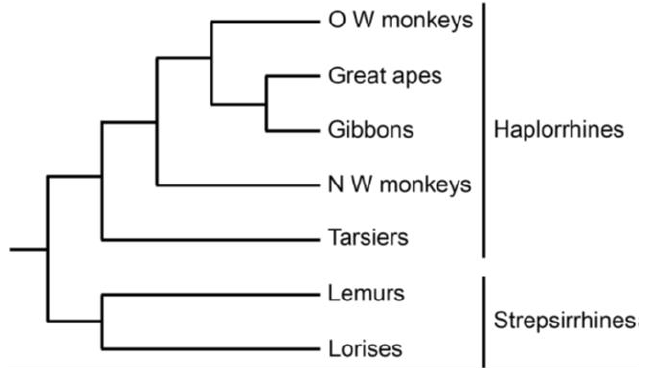
Figure 2. Classification of primates [12]. Strepsirrhines and haplorrhines are suborders, tarsiers are regarded as an infraorder, whilst the other clades shown are superfamilies. OW, Old World; NW, New World. Reprinted with permission from [2] © 2021 Society for Reproduction and Fertility.